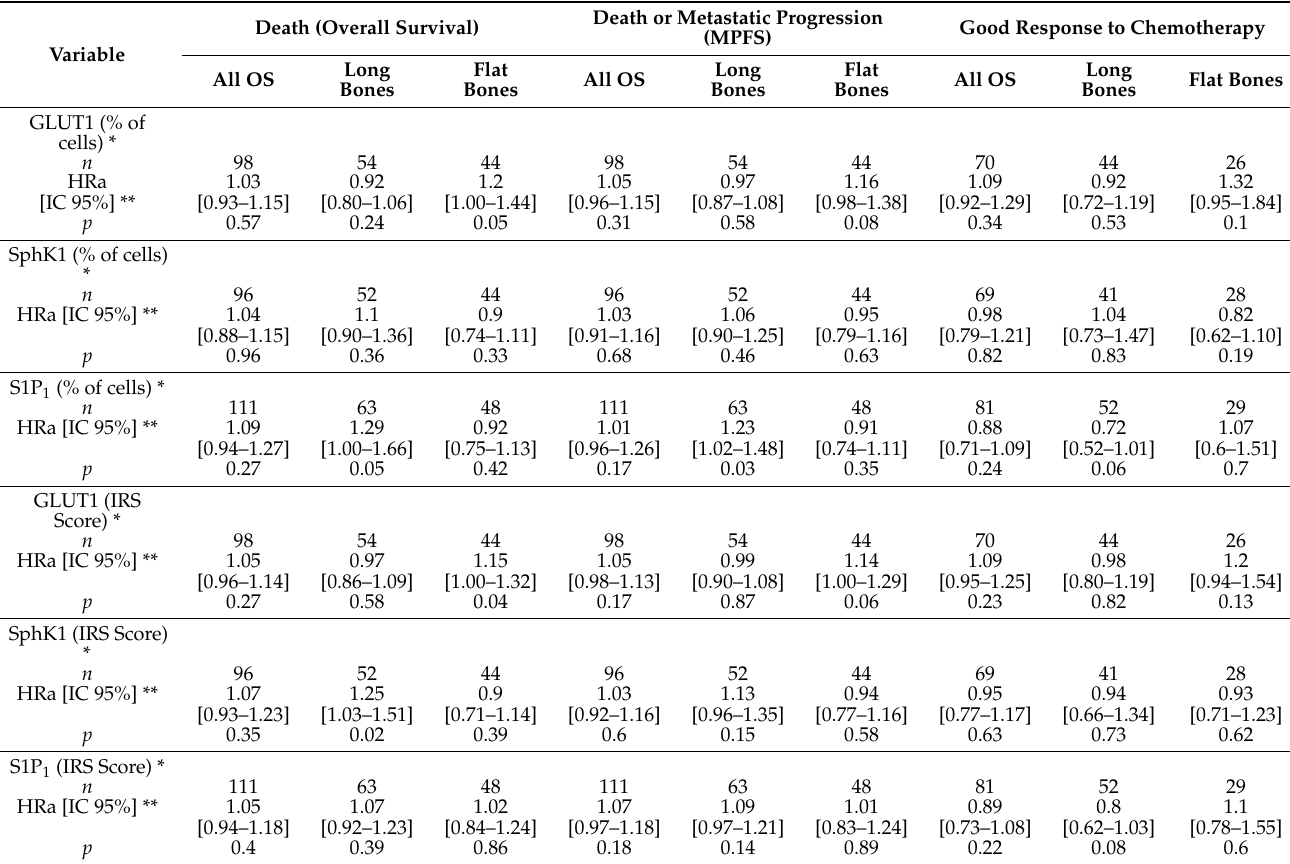
Table 6. Age-adjusted multivariate